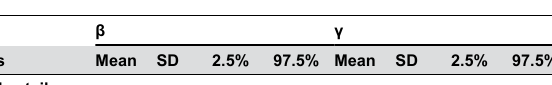
Table 3. Means and 95% confidence intervals of the posterior distribution of linear (β) and quadratic (γ) parameters in analyses of outcross pollen acquisition.